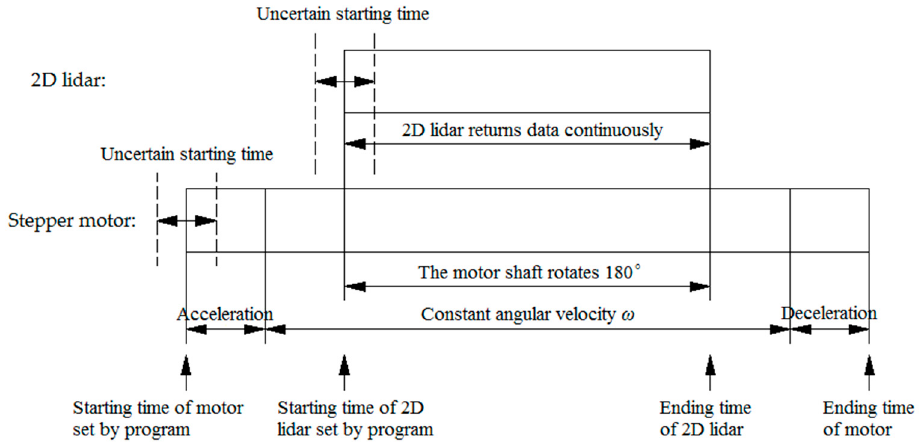
Figure 2. Improved action sequence of the 2D lidar and stepper motor.